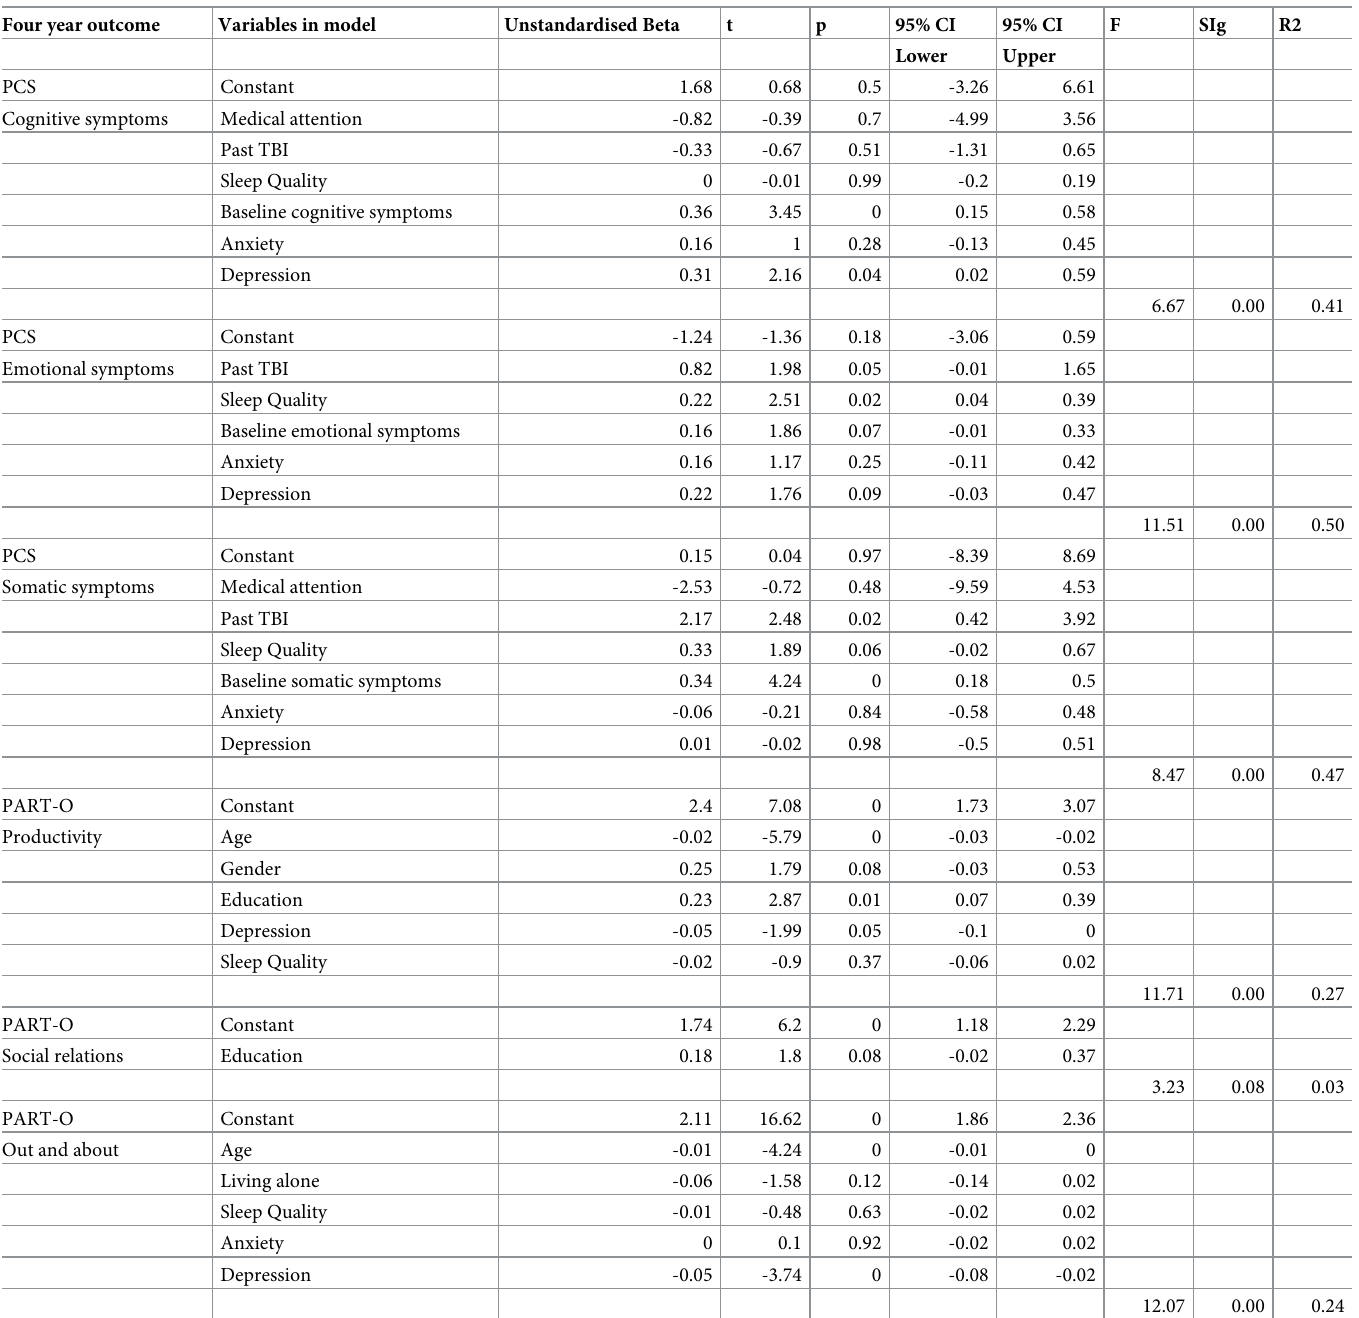
Table 3. Regression models of four year